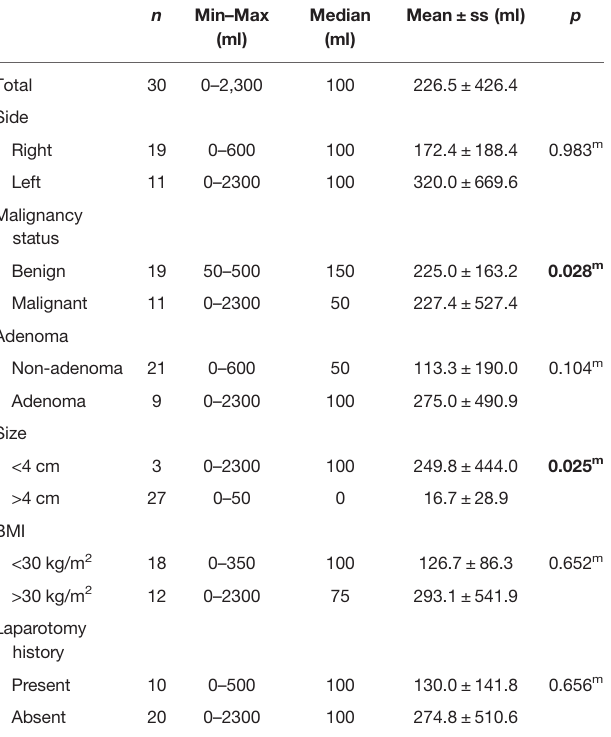
TABLE 5 | Hospital stay (days) for robotic adrenalectomy surgery according to the analyzed criteria. n Min – Max